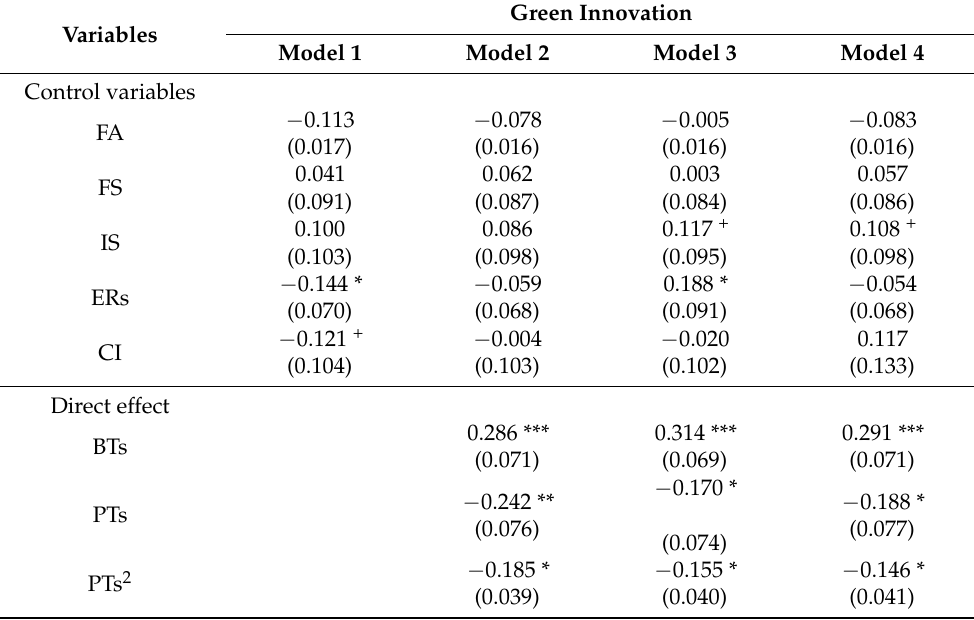
Table 3. Hierarchical regressions